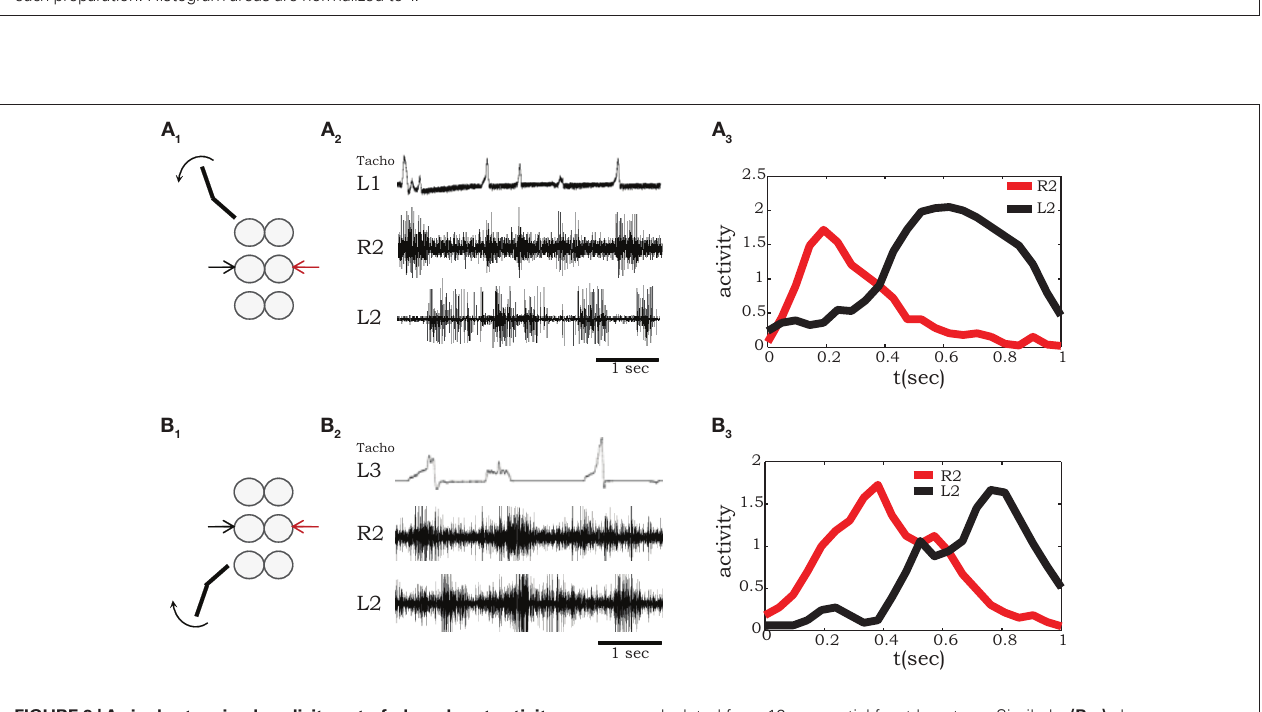
Figure 3 | A single stepping leg elicits out-of-phase burst activity in neighboring ganglia. (A ) Simultaneous extracellular recordings from 1,2 mesothoracic coxal levator MNs on both sides of the mesothoracic ganglion during single front-leg (L1) stepping (monitored by tachometer in the top panel). (A ) Shows averaged rectified activity in contralateral (red) and 3 ipsilateral (black) levator MNs in the adjacent segment (R2 and L2)